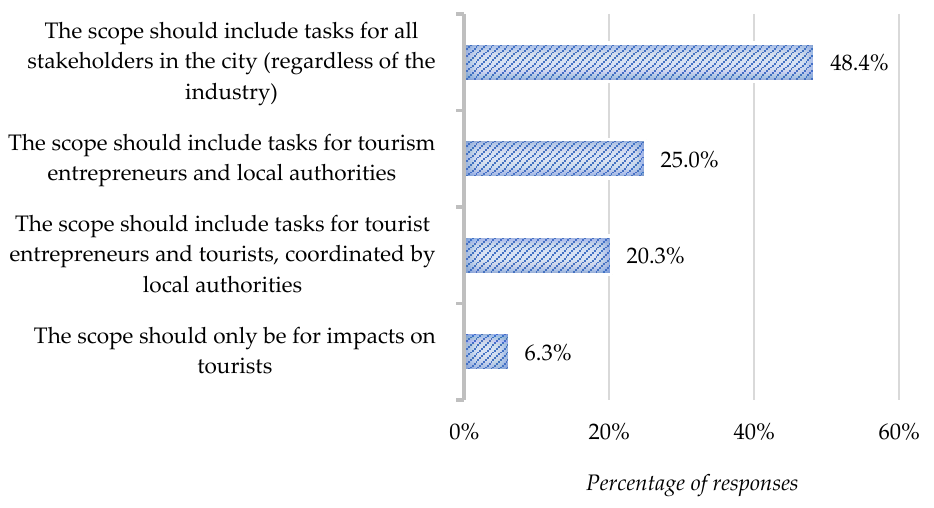
Figure 4. Distribution of answers to the question: ‘ What should be the scope of innovative solutions? ’ . Source: Own study.